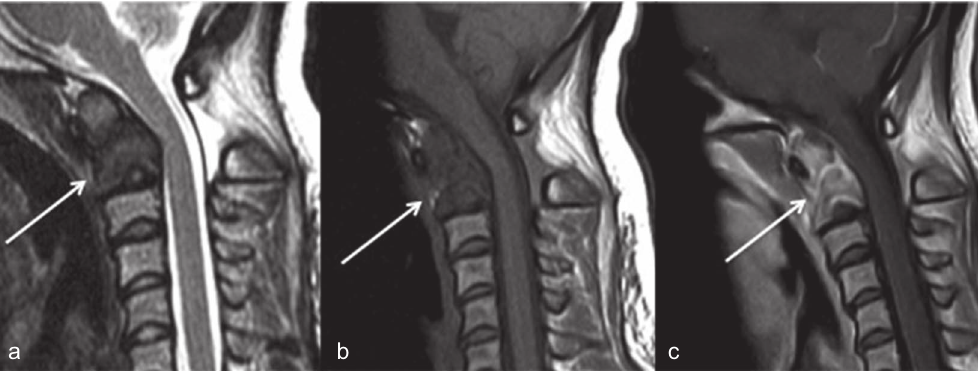
Figure 2. T2-weighted, T1-weighted, T1-weighted with intra-venous contrast administration midline sagittal MR images of the cervical spine showing the low signal intensity of the C2 vertebral body and odontoid process (a, b), with enhancement after contrast administration (c), and a solution at the junction between the odontoid process and vertebral body (a – c).